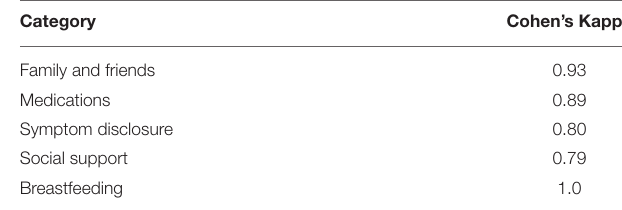
TABLE 2 | Interrater reliability for manual